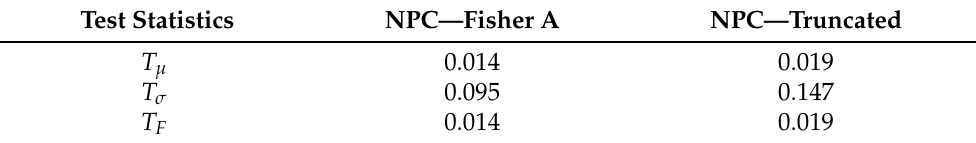
Table 7. Partial p